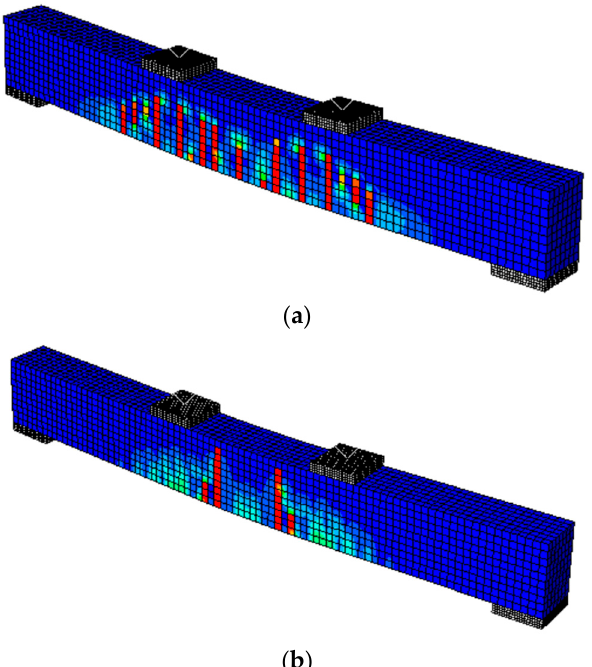
Figure 3. Flexural cracking of concrete beams, ( a ) the reference beam, ( b ) the beam with corroded steel bars.